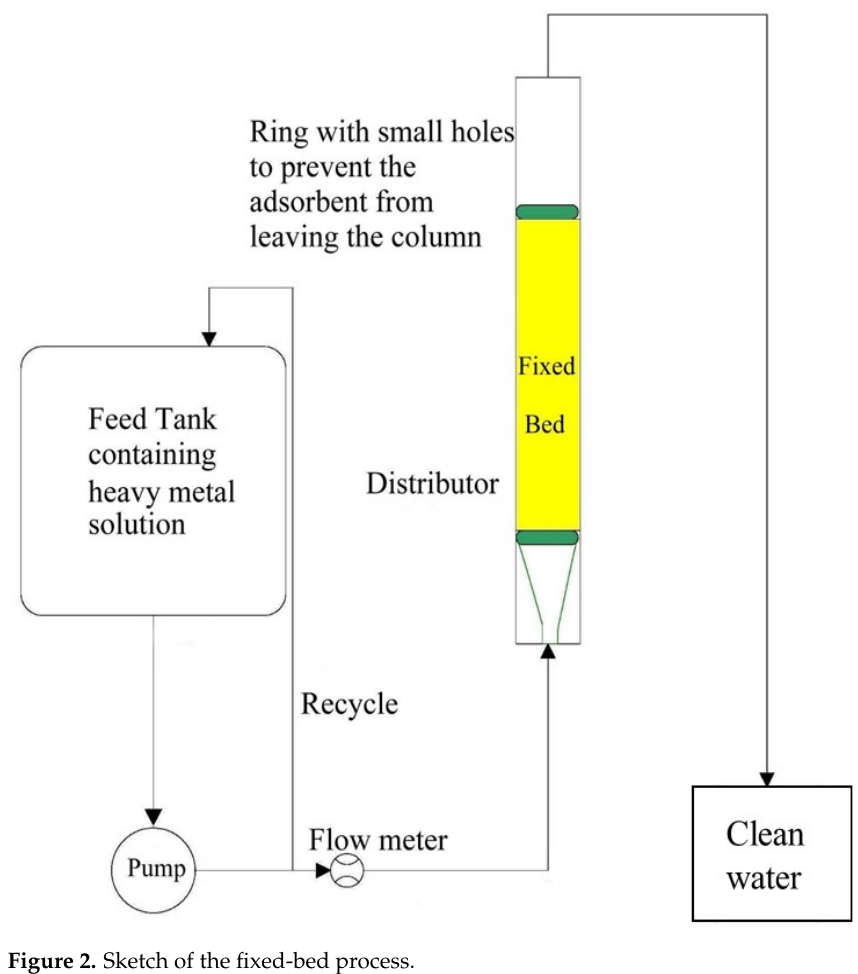
Figure 2. Sketch of the fixed-bed process.